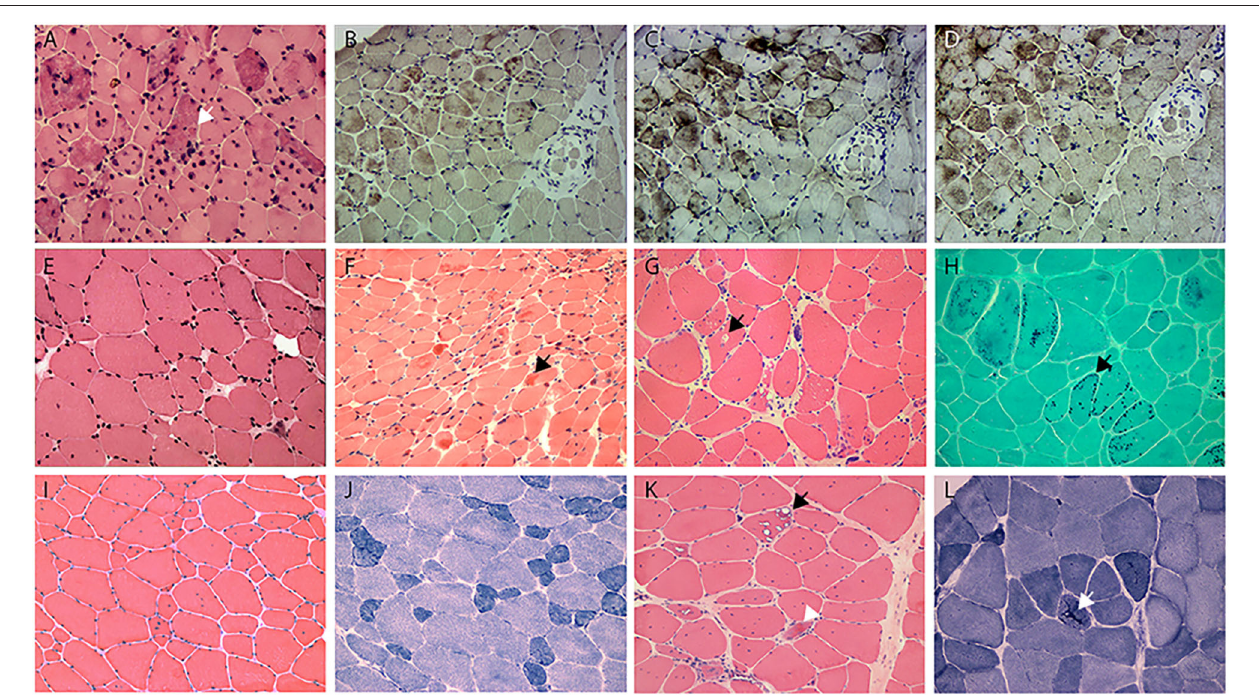
FIGURE 3 | Comparison of the FLNC intronic c.6004 + 3 nucleotide among different species. *indicates the conserved nucleotide.